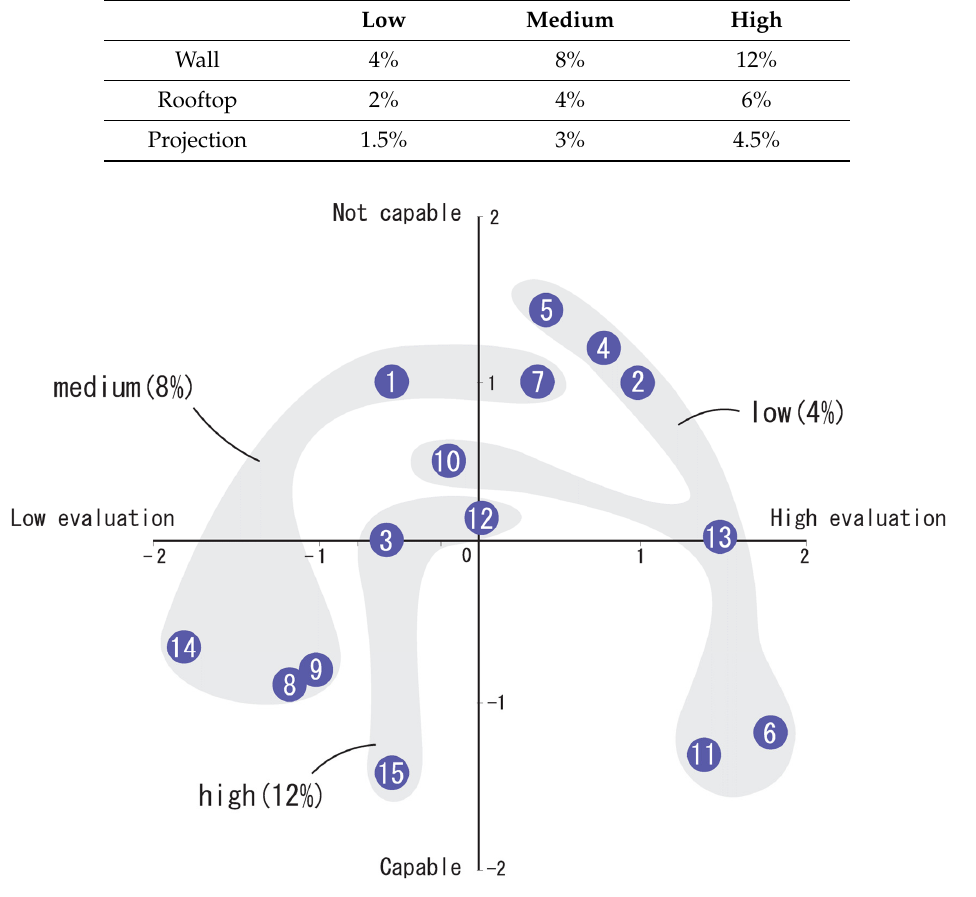
Figure 12. Scatter diagram based on the proportion levels (wall advertising signs).